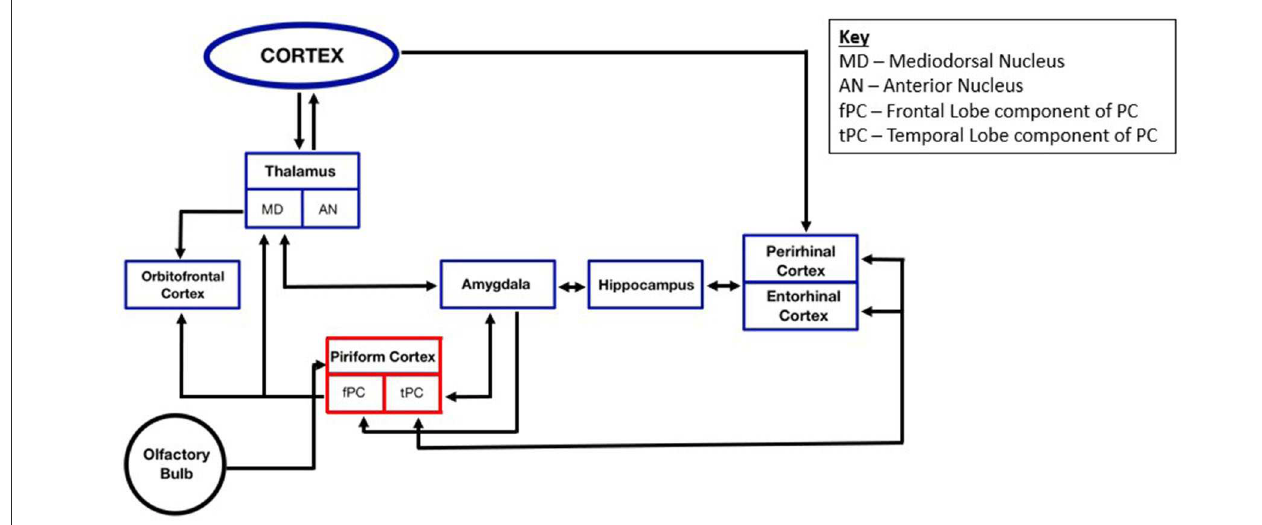
FIGURE2 Functional overview of piriform cortex connectivity within the temporal lobe epilepsy seizure